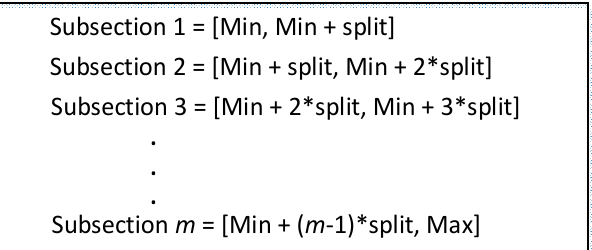
Figure 3. Solution representation procedures.